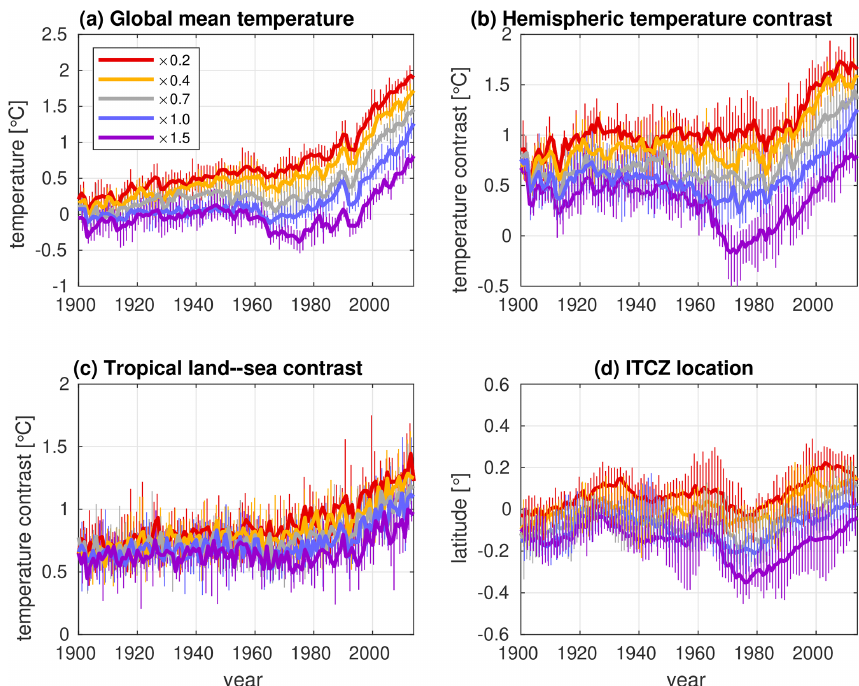
Figure 3. Time series of various atmospheric properties from the SMURPHS simulations: (a) global mean surface air temperature, expressed as an anomaly with respect to the mean value across the five members of the × 1 . 0 experiment in the period 1900–1929; (b) hemispheric temperature contrast (NH minus SH); (c) tropical land–sea temperature contrast, calculated in the summer months (November–March in SH, May–September in NH) for latitudes within 30 ◦ S and 30 ◦ N only; (d) global mean ITCZ location, calculated following Adam et al. (2016; see text for a description of the method). All values are ensemble means; vertical error bars indicate the range across the five ensemble